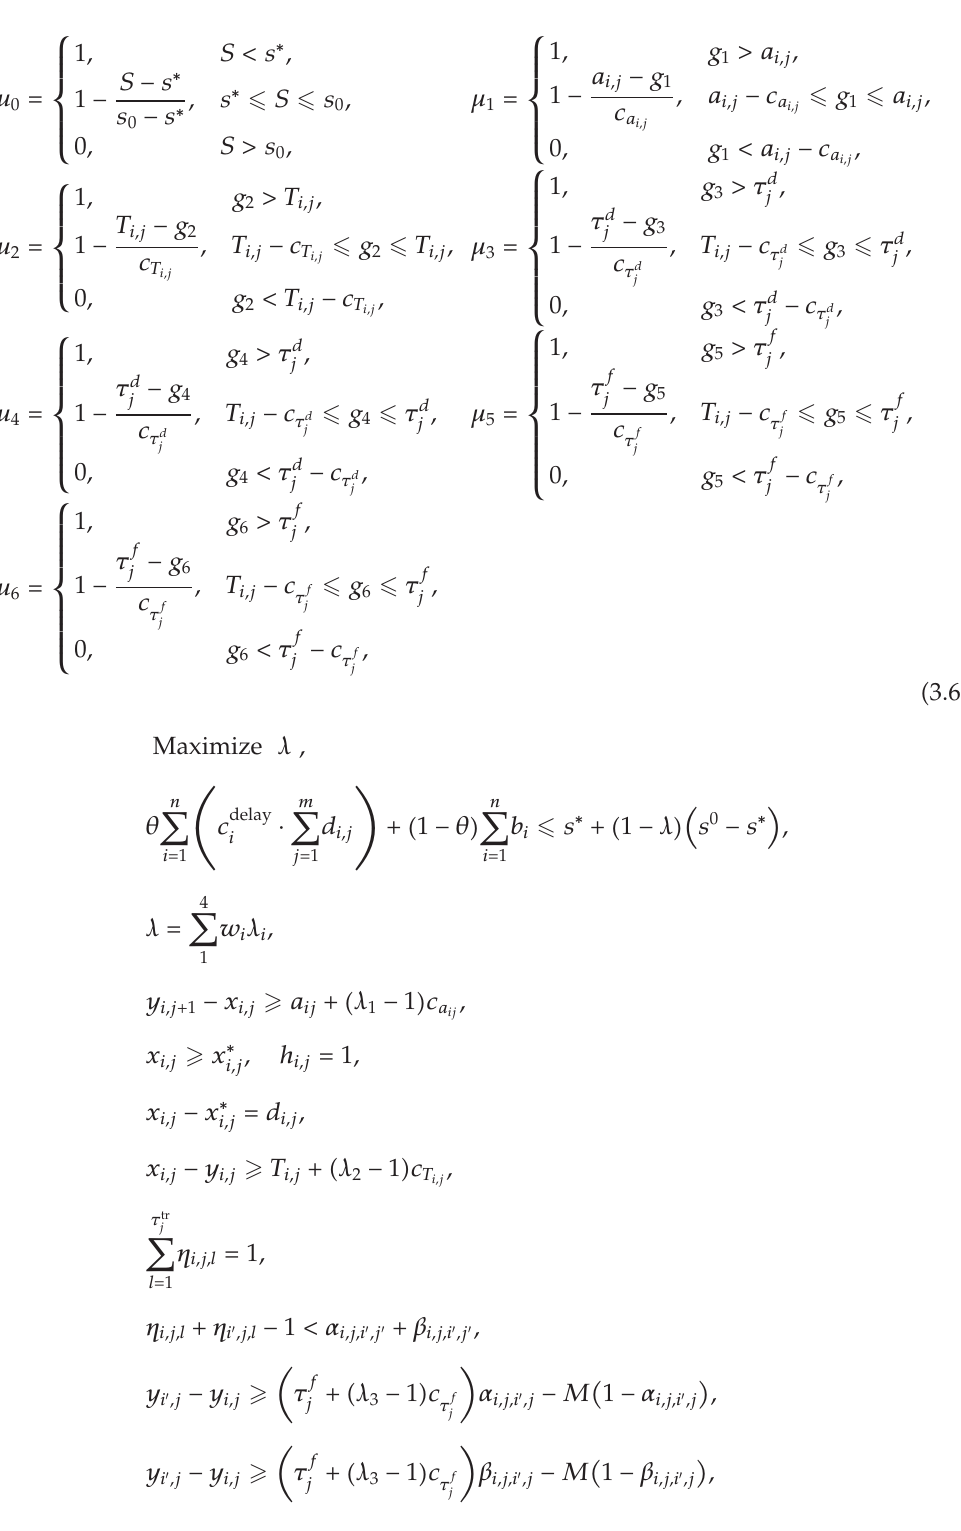
and operation. (cid:5) 3 (cid:6) Refer to the train safety operation specifications under di ff erent emergency